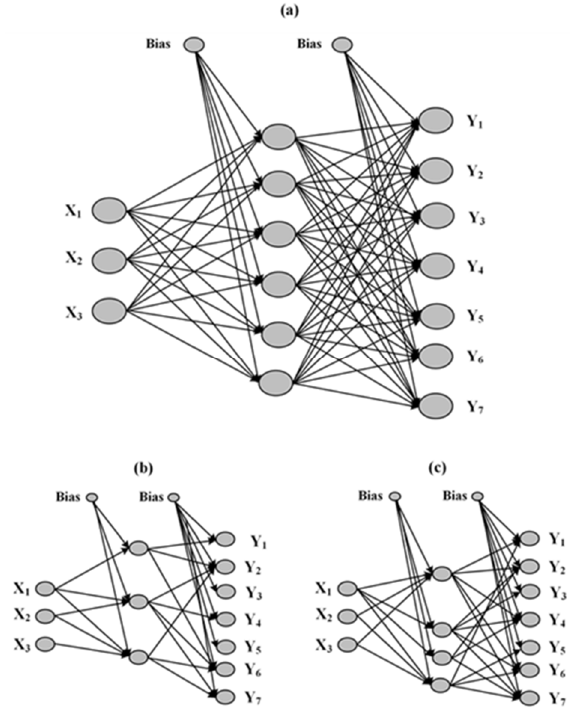
Figure 8. Optimal ANN structure based on the DoE results ( a ) and ANN structures after pruning with magnitude-based pruning (MBP) ( b ) and optimal brain damage (OBD) ( c ) algorithms.